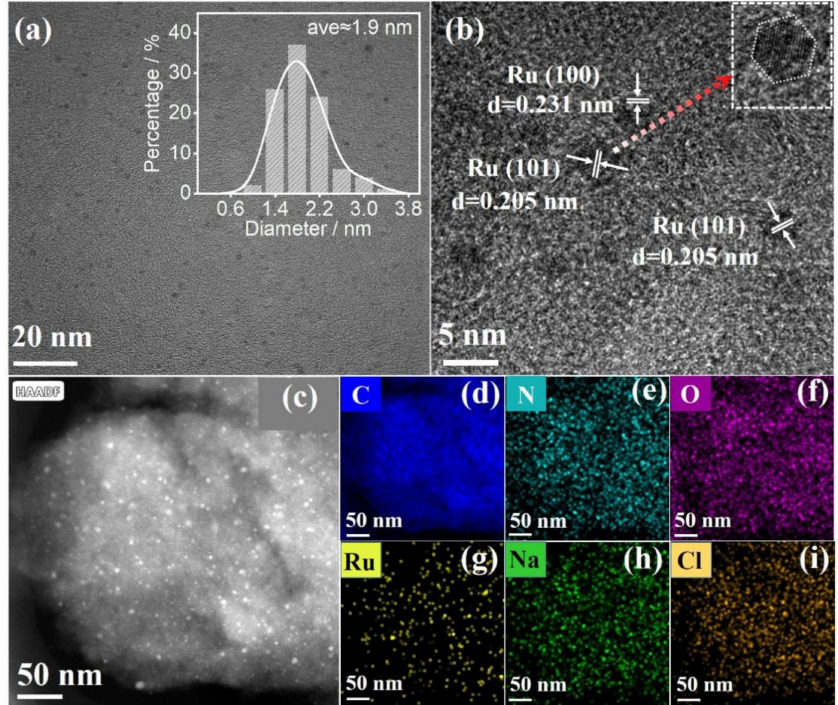
Figure 2. ( a ) TEM image of Ru 0.3 /C − 800 (inset: the corresponding Ru NPs size distribution his- togram); ( b ) HRTEM image of Ru 0.3 /C − 800; ( c ) HAADF-STEM image of Ru 0.3 /C − 800; ( d – i ) Ele- mental mappings for C, N, O, Ru, Na, and Cl in Ru 0.3 /C − 800,